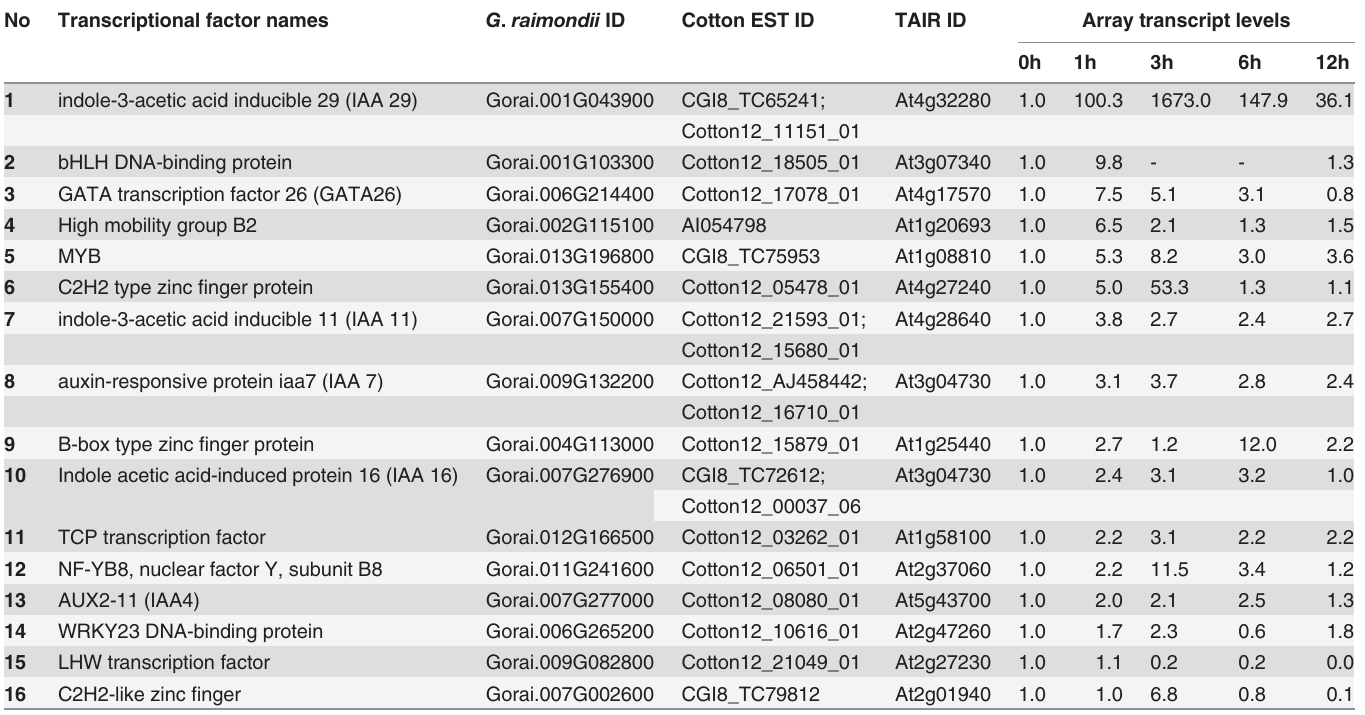
Table 1. Transcription factors regulated in pre-anthesis cotton ovules (-1 DPA) by auxin and